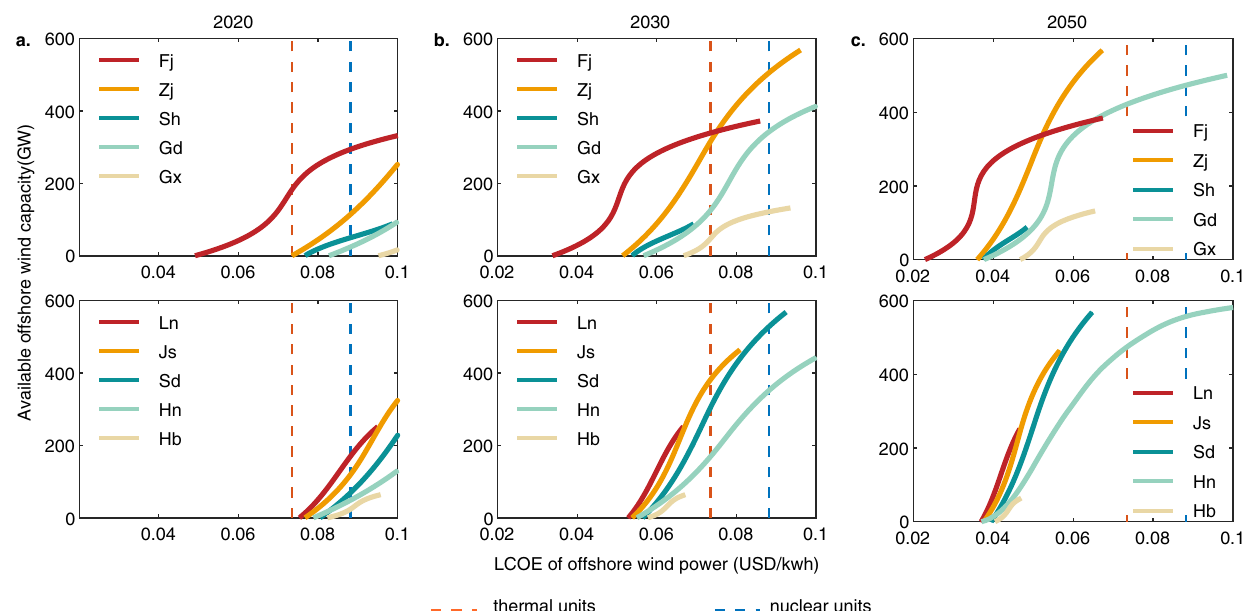
Fig. 2 | Offshore wind supply curves for all the coastal provinces at different targetingyears. Provincialsupplycurvesfor2020,2030and2050areindicatedin a , b , and c respectively. Cumulative offshore wind capacity available at each LCOE